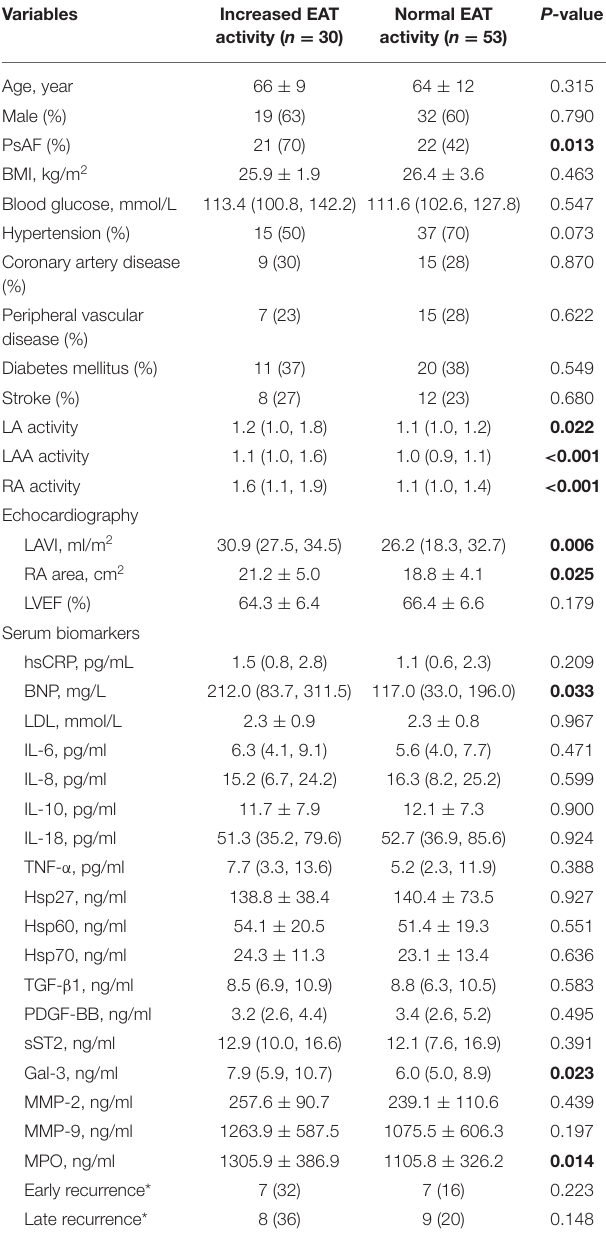
TABLE 2 | Comparison between patients with- and without increased EAT activity.